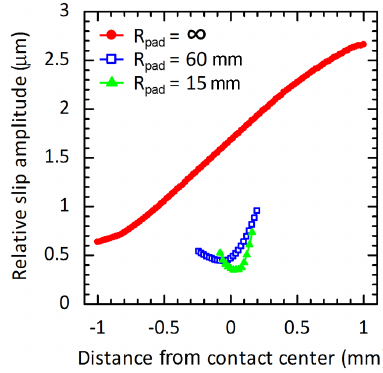
Figure 11. Relative slip amplitudes along contacts of fretting fatigue experiments at a stress amplitude of 300 MPa.